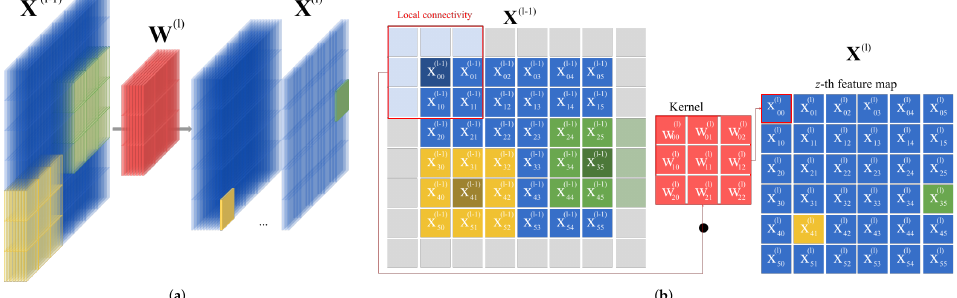
Figure 2. Graphical representation of a convolution kernel. ( a ) The multidimensional array of weights W ( l ) (in red) is slid and locally applied over regions on the input feature maps X ( l − 1 ) (highlighted in green and yellow), obtaining the corresponding output features in X ( l ) as a weighted sum. ( b ) 2D detail of a 3 × 3 kernel with stride 1 and zero padding. Index l denotes the l -th layer, subscripts i , j ∈ [ 0,5 ] represent the spatial coordinates of the features, whilst z indicates the